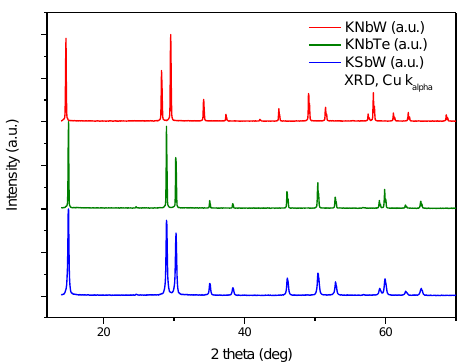
Figure 1. XRD patterns of KNbW, KNbTe and KSbW at 298 K, characteristic of a single-phase, cubic pyrochlores. The progressive shift to higher 2 θ angles stands for unit-cell parameter reduction. Table 1. Unit–cell, fractional atomic coordinates, atomic displacement parameters, refined occupancy factors and Rietveld agreement factors of KNbW, KNbTe and KSbW, with cubic space group Fd 3 m (No. 227) and Z = 8, from NPD data at 298 K ( λ = 1.59468(1)